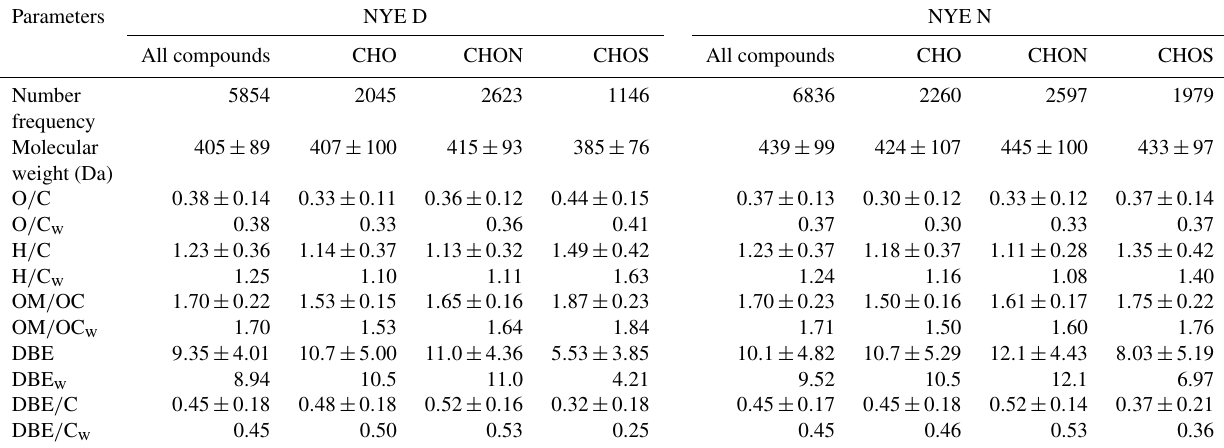
Table 2. The number of compounds in each subgroup and arithmetic and weighted mean elemental ratio for each subgroup in NYE D and NYE N